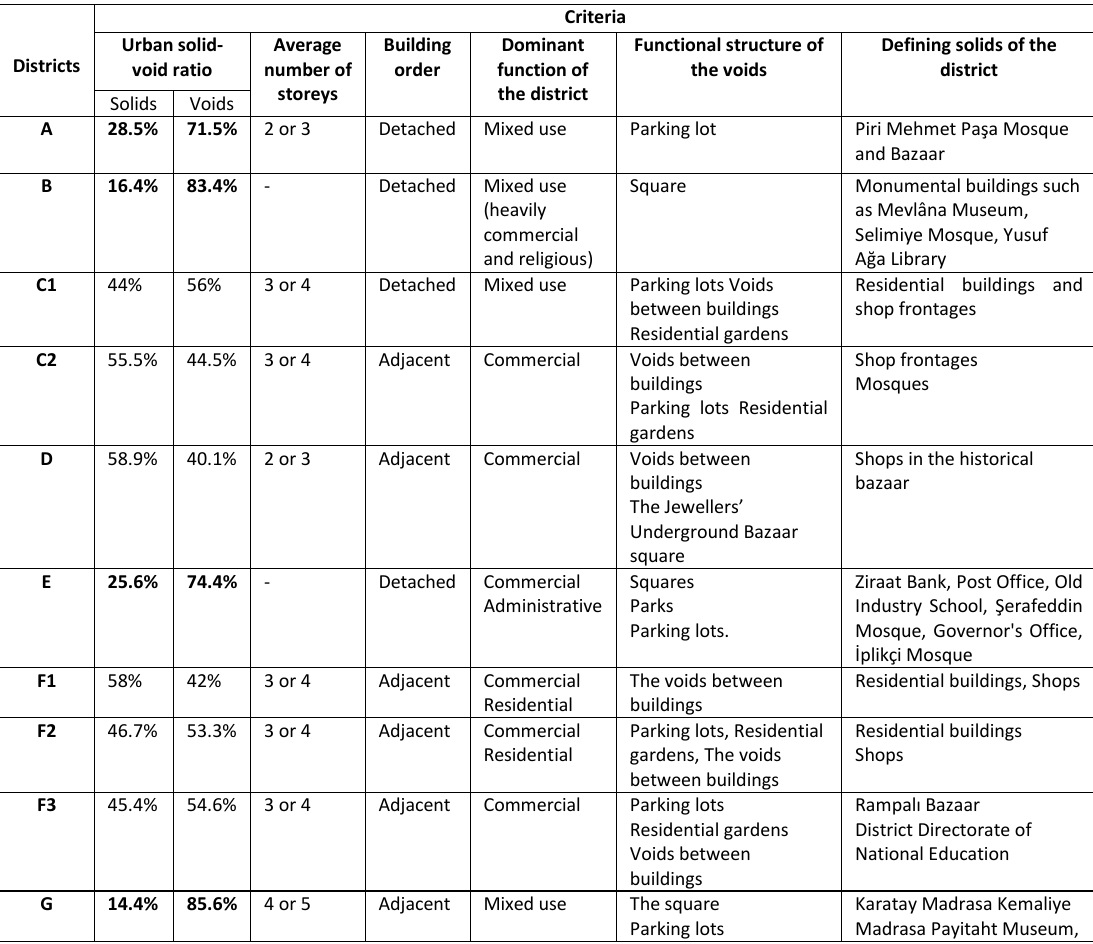
Table 1 Observation and calculation results of the figure-ground analysis